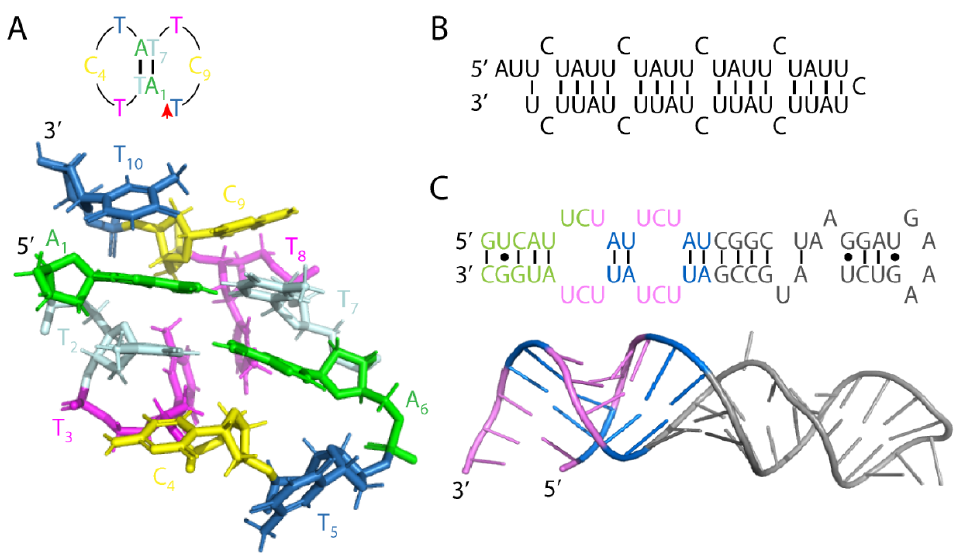
Figure 1. SCA10 repeat DNA and RNA structures. ( A ) Schematic and high-resolution NMR structure (PDB entry 6IY5) of an (ATTCT) 2 DNA mini-dumbbell. Each mini-dumbbell is composed of a TTCTA and a quasi TTCT/A pentaloops. The red arrow indicates the backbone discontinuity site. ( B ) The proposed NMR structure of an (AUUCU) 9 RNA hairpin. ( C ) Schematic and crystal structure (PDB entry 5BTM) of two (AUUCU) 2 repeats separated by 25 ribonucleotides (grey). The 5 ′ UCU 3 ′ / 3 ′ UCU 5 ′ loops and AU base pairs are highlighted in pink and blue, respectively. Green ribonucleotides are missing in the final crystal structure.